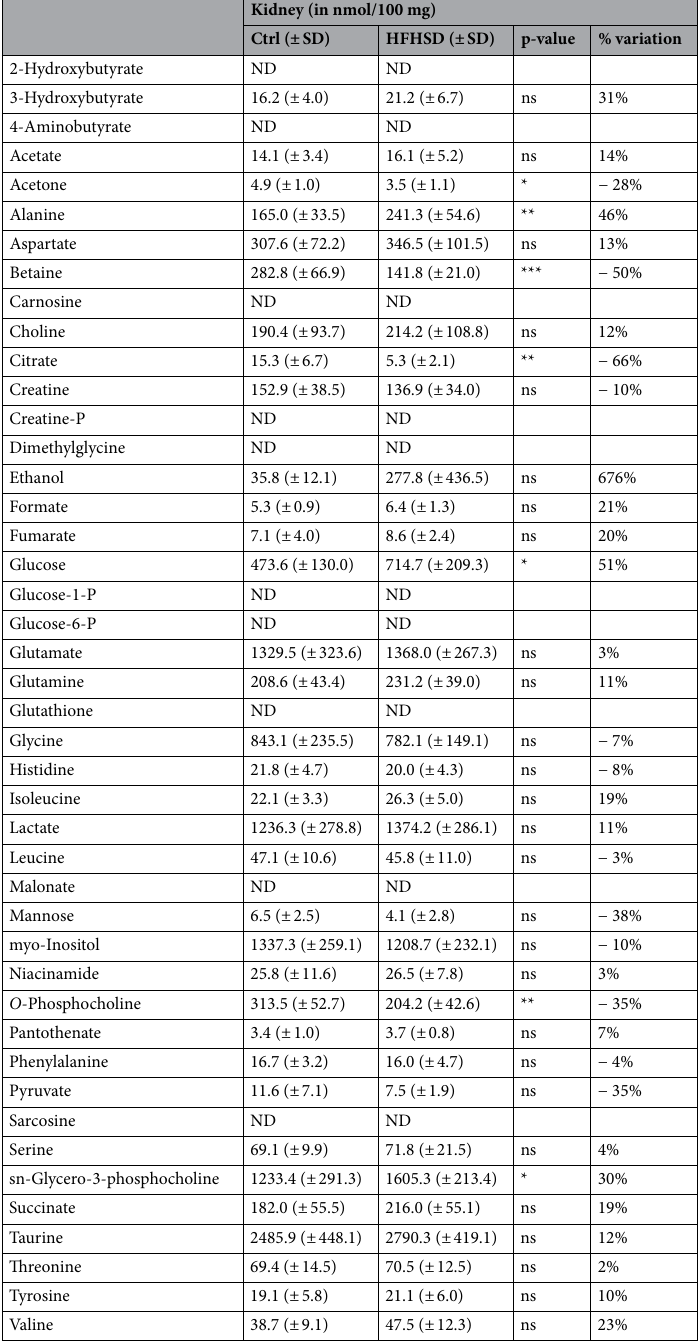
Table 7. Metabolite concentrations measured by NMR in the kidney of SD and HFHSD mice. Results are expressed as mean ± standard deviation (SD) and are in nmol/100 mg of kidney. Data are mean of n = 8 mice per group; Results of unpaired two-tailed t-test are indicated as non-determined (ND), non-significant (NS), p < 0.05 (*), p < 0.01 (**), p < 0.001 (***) and p < 0.0001 (****). Percentages of variation between HFHSD and control fed mice are